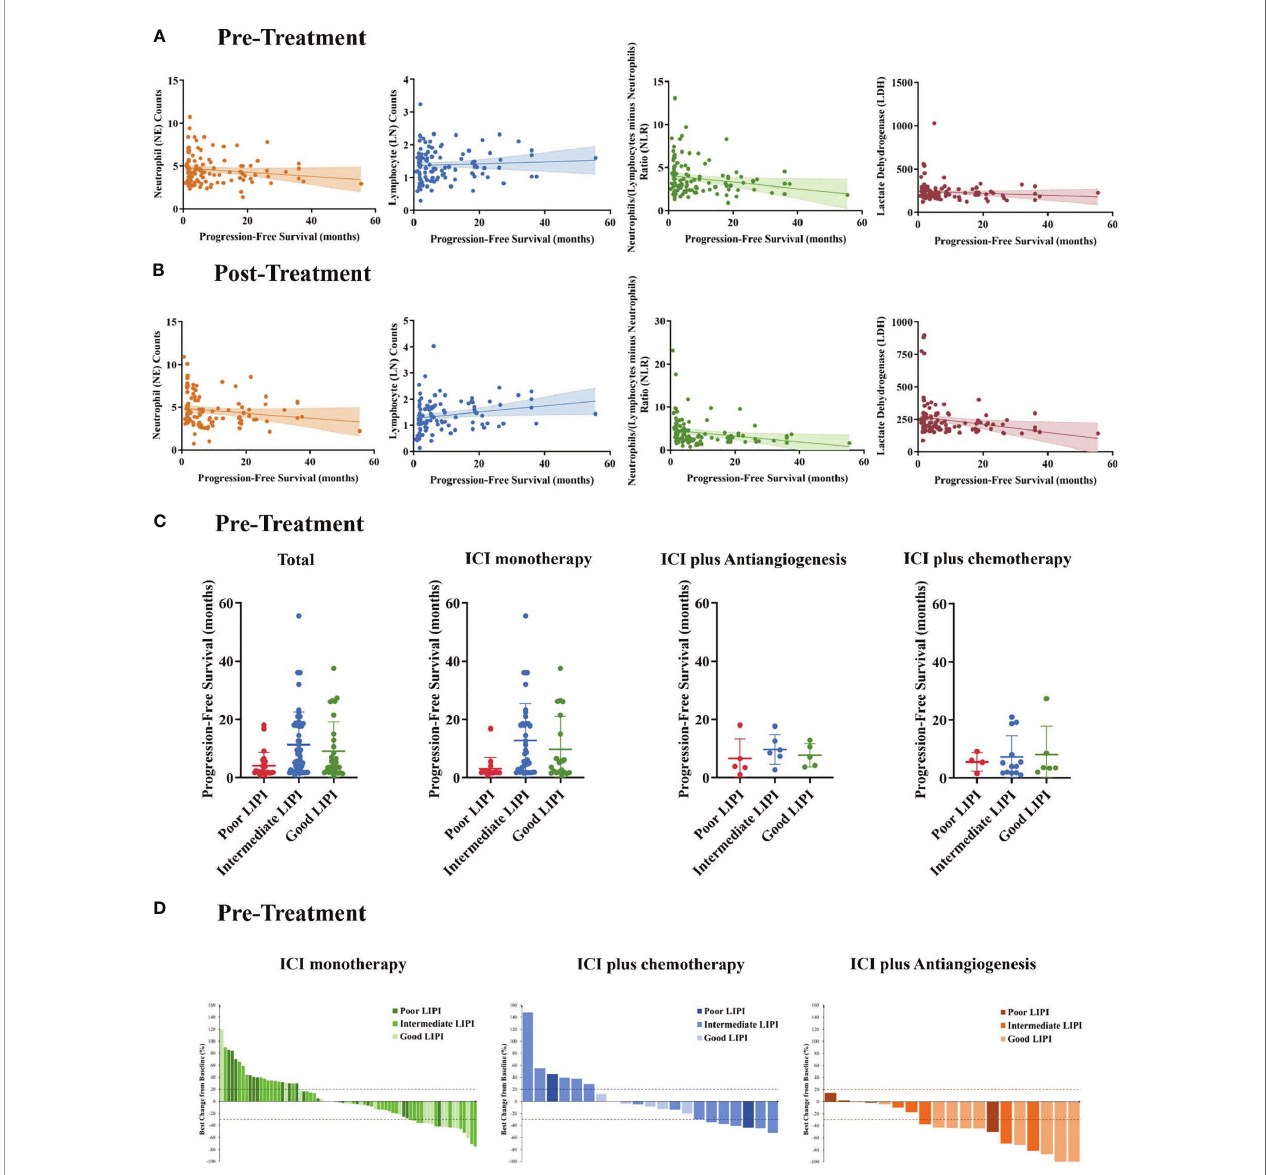
FIGURE 3 | Pre- and post-treatment biomarker measurements. The associations between pre- (A) and post-treatment (B) neutrophil (NE) counts, Lymphocyte (LN) counts, neutrophil/lymphocyte ratios (NLRs), and the serum lactate dehydrogenase (LDH) level with progression-free survival (PFS). (C) PFS strati fi ed by the lung immune prognostic index (LIPI) score in all patients, the ICI monotherapy group, the ICI plus anti-angiogenic agent (ICI+A) group, and the ICI plus chemotherapy (ICI+C) group. (D) Waterfall plots showing the best responses and the LIPI scores in the ICI monotherapy (green panel), ICI+A (blue panel), and ICI+C (orange panel) groups. The LIPI is based on an NLR greater than 3 and an LDH level greater than the upper limit of normal. ICI, immune checkpoint